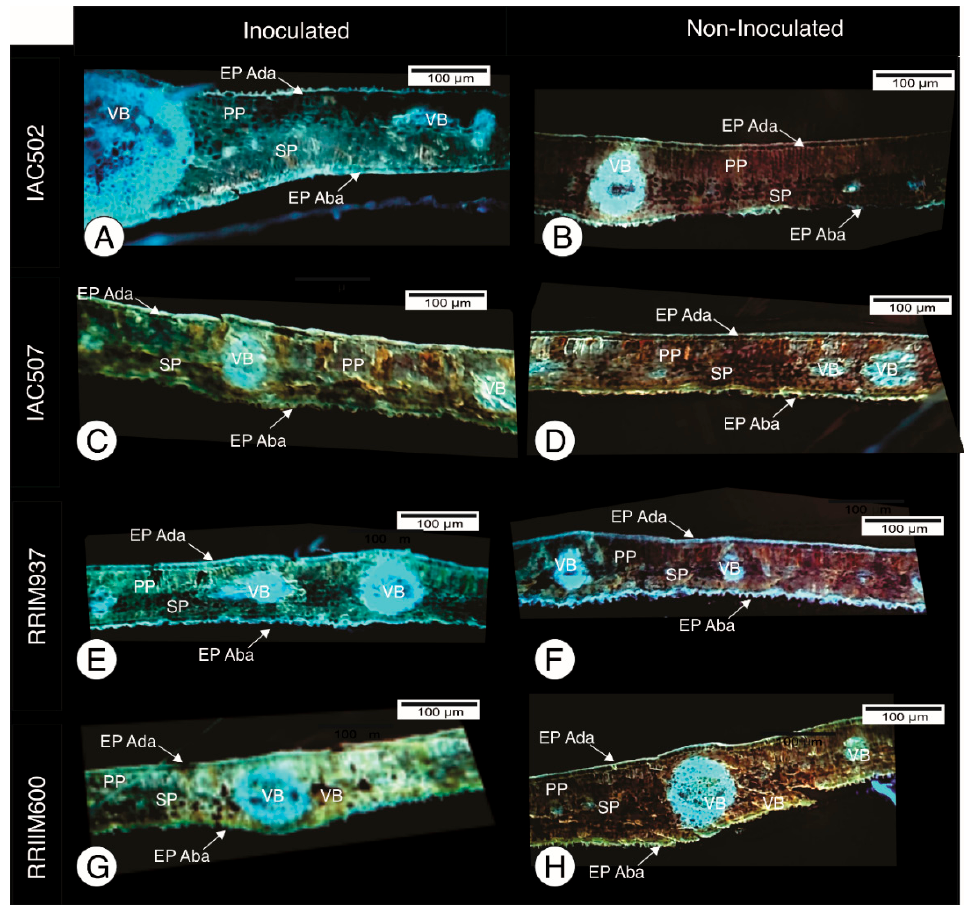
Figure 3. Histological sections under UV light, for lignin visualization (blue fluorescence), from clones IAC 502 ( A , B ), IAC 507 ( C , D ), RRIM 937 ( E , F ) and RRIM 600 ( G , H ). pl: spongy